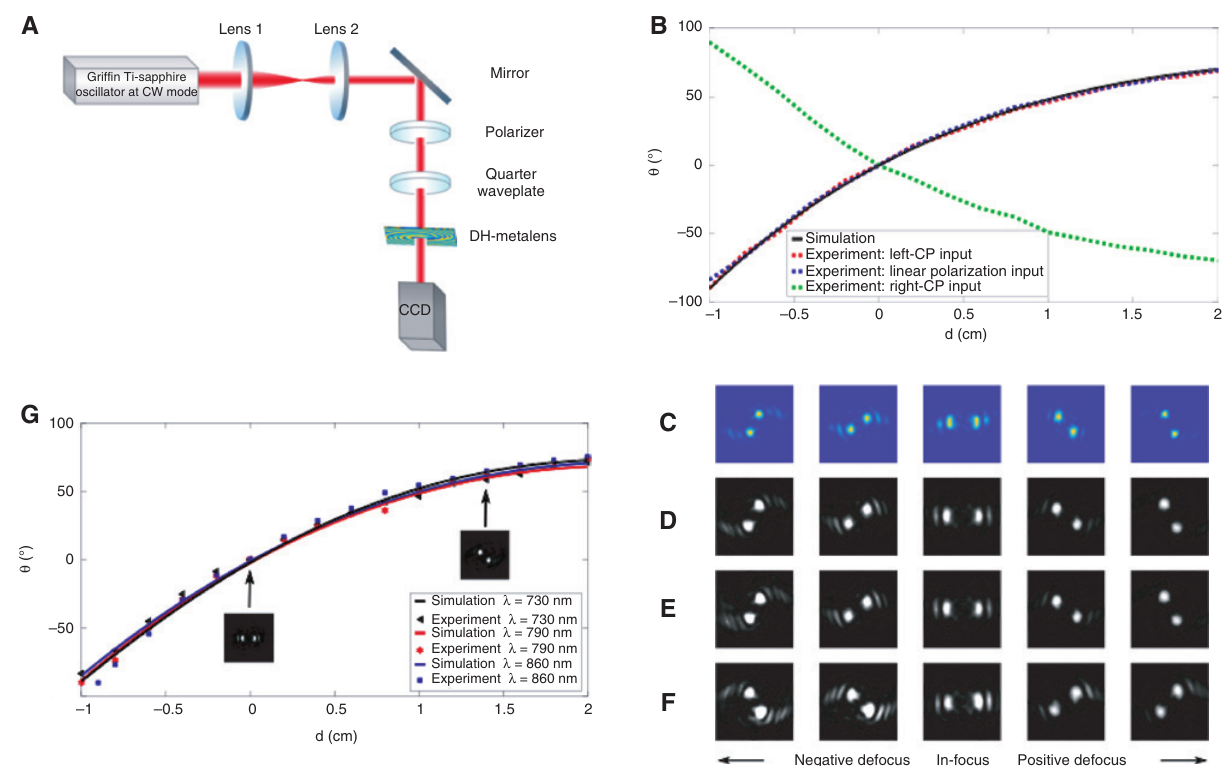
Figure 3: Experimental setup and characterization of the DH-metalens. (A) Schematic diagram of the experimental setup to characterize the PSF of the DH-metalens. (B) Theoretically calculated and experimentally obtained relationship curves between the rotation angle ( θ ) and the imaging defocus ( d ) at wavelength of 750 nm. (C–F) The rotation of DH-PSF images at different defocus positions in theory (C) and in experiment with left-CP input (D), linear polarization input (E), and right-CP polarization input from the back side (F). (G) Relationship curves between θ and d at wavelengths of 730 nm, 790 nm, and 860 nm; the insets are two DH-PSF images at a wavelength of 730